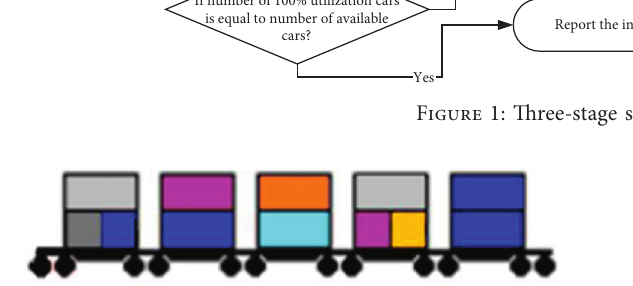
Figure 2: A 5-well rail